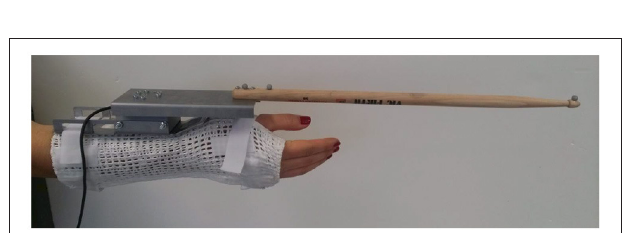
FIGURE 5 | Drumming cuff with the stiff connection.